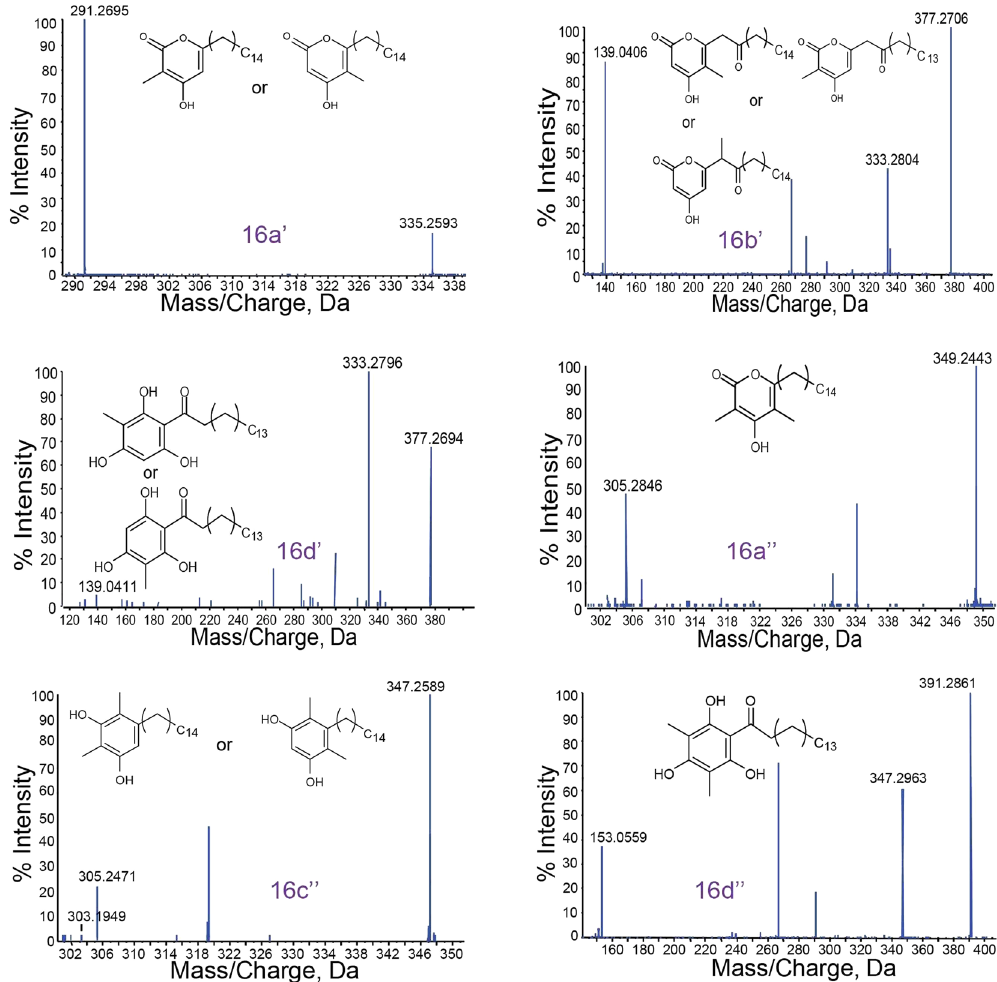
Figure 4. Triple-TOF HRMS identification of novel methylated tetraketide reaction products of MMAR_2474 protein. Tandem MS/MS spectra for each product of MMAR_2474 protein from assays carried out with palmitoyl-CoA (C 16 -CoA) as starter substrate and both malonyl- and methymalonyl-CoA as